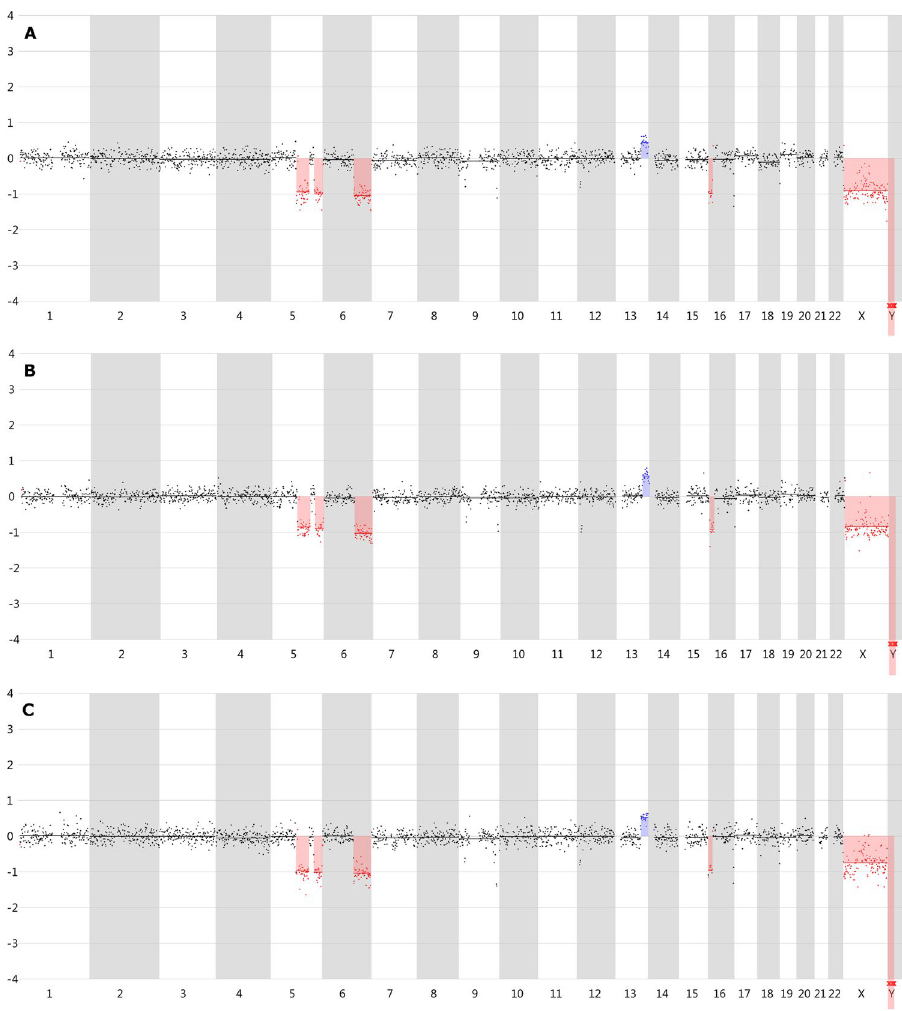
Figure 4. CNV line profiles generated with Vivar using 1 Mb windows. Representative CNV line profile of a ( A ) 1-cell sample amplified with Ampli1. ( B ) 1-cell sample amplified with DOPlify. ( C ) 1-cell sample amplified with PicoPLEX. Segments in red represent deletions, whereas blue segments indicate duplications. As REPLI-g did not result in reliable CNV profiles, it was omitted from this